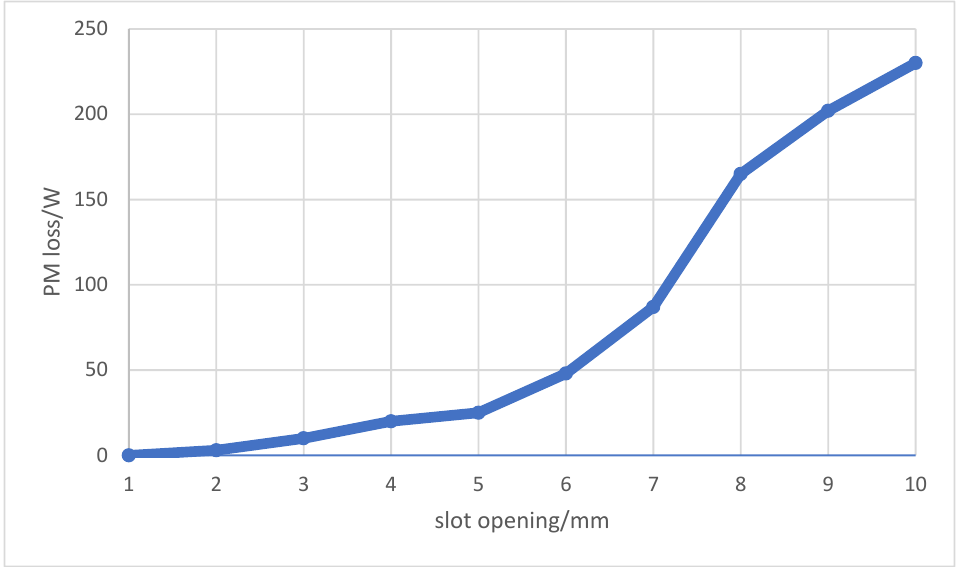
Figure 8. The relationship between the rotor permanent magnet and slot opening under the no-load